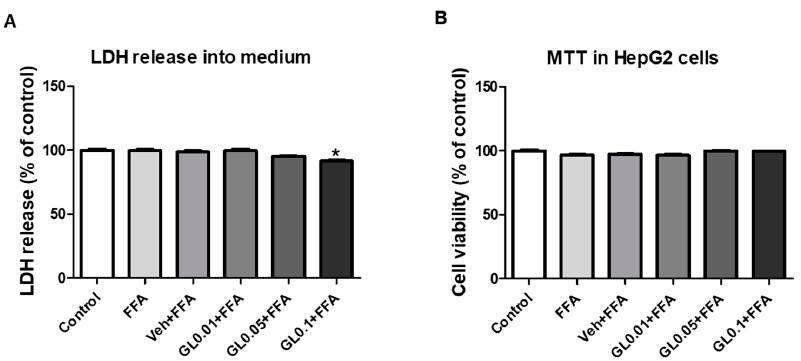
Figure 8. Cytotoxicity of GL in HepG2 cells. ( A ) LDH level in cultured medium. ( B ) MTT assay in